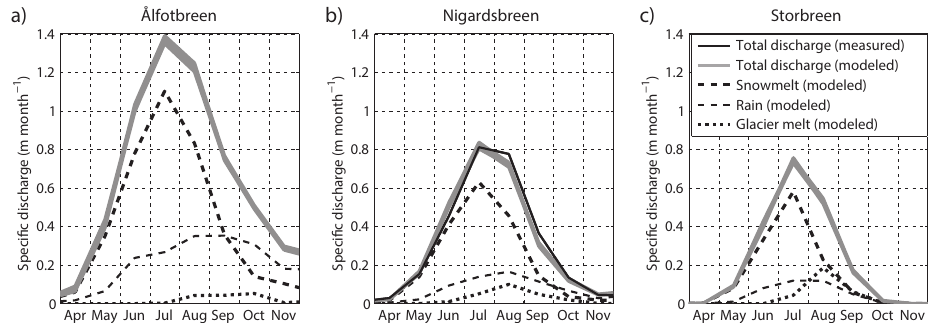
Fig. 9. Modelled monthly discharge rates and their contributing sources for Ålfotbreen, Nigardsbreen and Storbreen averaged for the period 1991–2000. Data for the contributing sources represent the mean of the 100 best model runs.